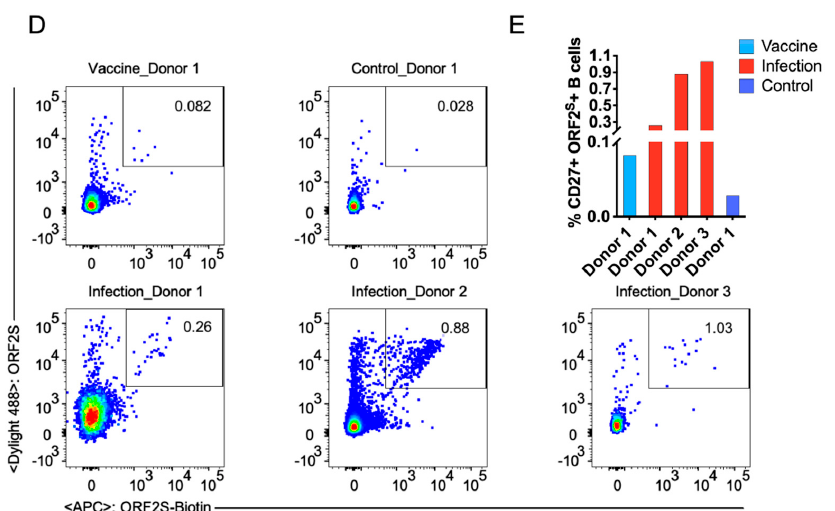
Figure 4. Analyses of the antibody response to ORF2 S in plasma and B cells. ( A ) Serial dilutions of plasma samples separately bound to ORF2 S (tPA) and p239. The WHO standard serum was used as a reference to quantify the titer of anti-HEV IgG in naturally infected patients. The black lines are drawn between the same plasma samples. ****, p < 0.0001. ( B ) Correlation of anti-HEV IgG titers measured for ORF2 S (tPA) (Y axis) and p239 (X axis). The black line indicates the fitted linear regres- sion. The 95% confidence intervals (CI) are shown in silver. ****, p < 0.0001. ( C ) Comparison of anti- HEV IgG titers between ORF2 S and p239. Solid red dots indicate increased anti-HEV IgG titers, and solid blue dots indicate decreased anti-HEV IgG titers binding to ORF2 S (tPA), compared with p239. Data for anti-HEV IgG titers binding to ORF2 S (tPA)/p239, converted to log2. ( D ) Calibration with nonspecific memory B cells using control cells from healthy donors (top right). The proportions of ORF2 S -specific memory B cells are recognized by two fluorescently labeled ORF2 S (tPA) probes (la- beled with DyLight 488 and allophycocyanin (APC), respectively). Recognized memory B cells from HEV 239-vaccinated donors are shown at the top left. ORF2 S -specific memory B cells from HEV- infected donors are highlighted in boxes (bottom). ( E ) The proportions of ORF2 S -specific memory B cells are displayed as columns. Light blue, red, and dark blue columns indicate vaccinated, naturally infected, and control donors, respectively.